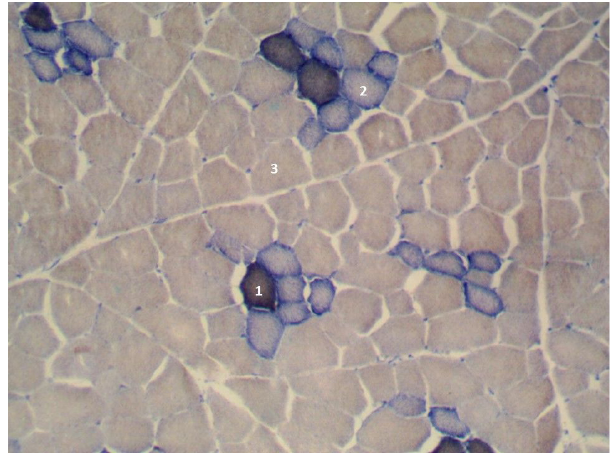
Figure 1. Cross section of the longissimus lumborum muscle in DanBred pig. Magnified 100 times. STO is indicated by 1, FTO is indicated by 2 and FTG is indicated by 3.